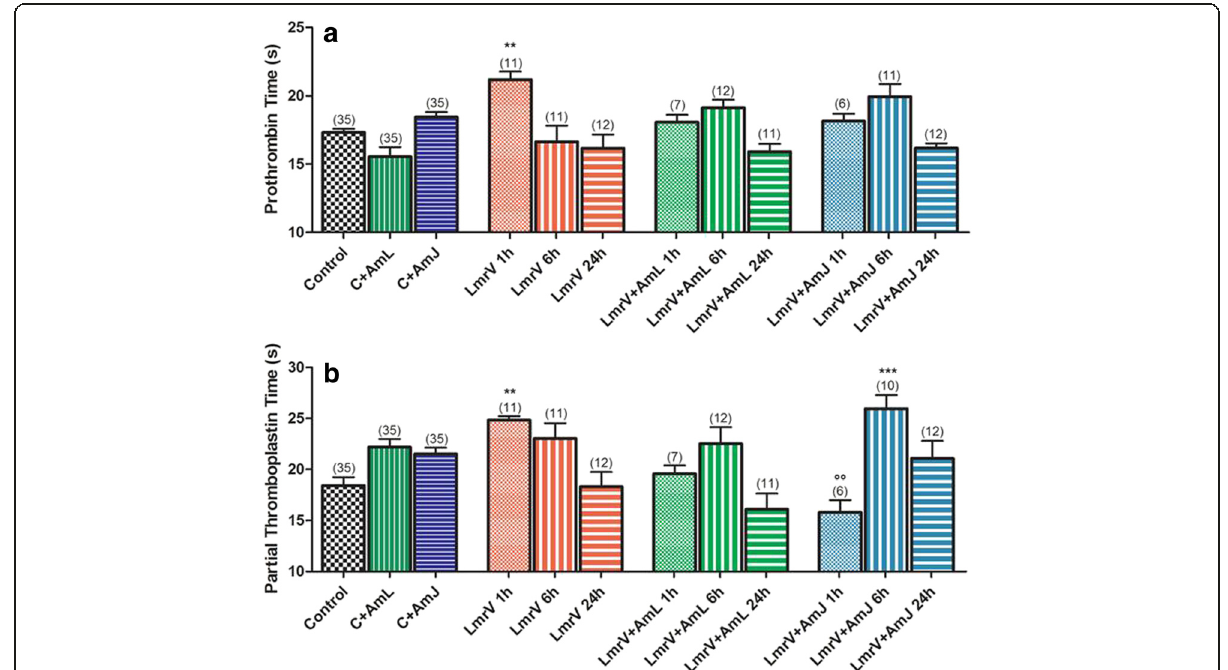
Fig. 3 a Determination of prothrombin time and b partial thromboplastin time in plasma of male Wistar rats injected with 3 mg of Lachesis muta rhombeata venom, at 1, 6 and 24 h after envenomation (LmrV) and with their respective treatments with aqueous extract of Annona muricata L. leaves (LmrV + AmL) or Annona muricata L. juice (LmrV + AmJ). The numbers above the columns represent the number of animals used in each